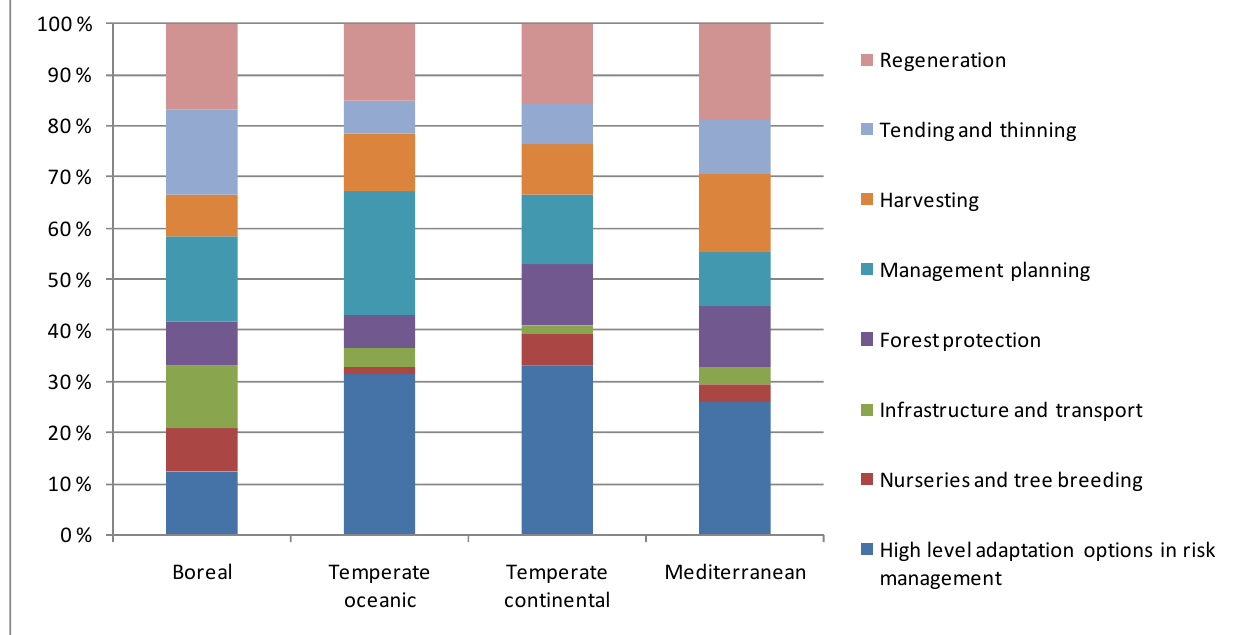
Figure 1. Type of measures applied in different bioclimatic regions based on ECHOES